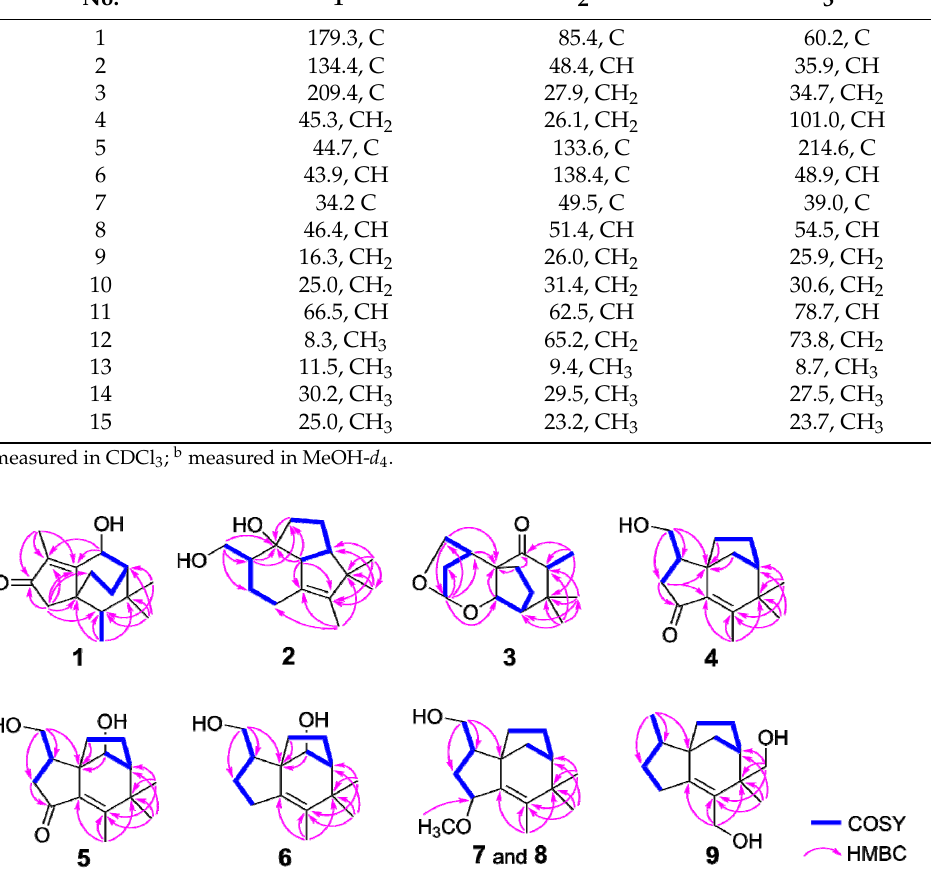
Figure 3. Key NOE correlations of compounds 1 – 9 .